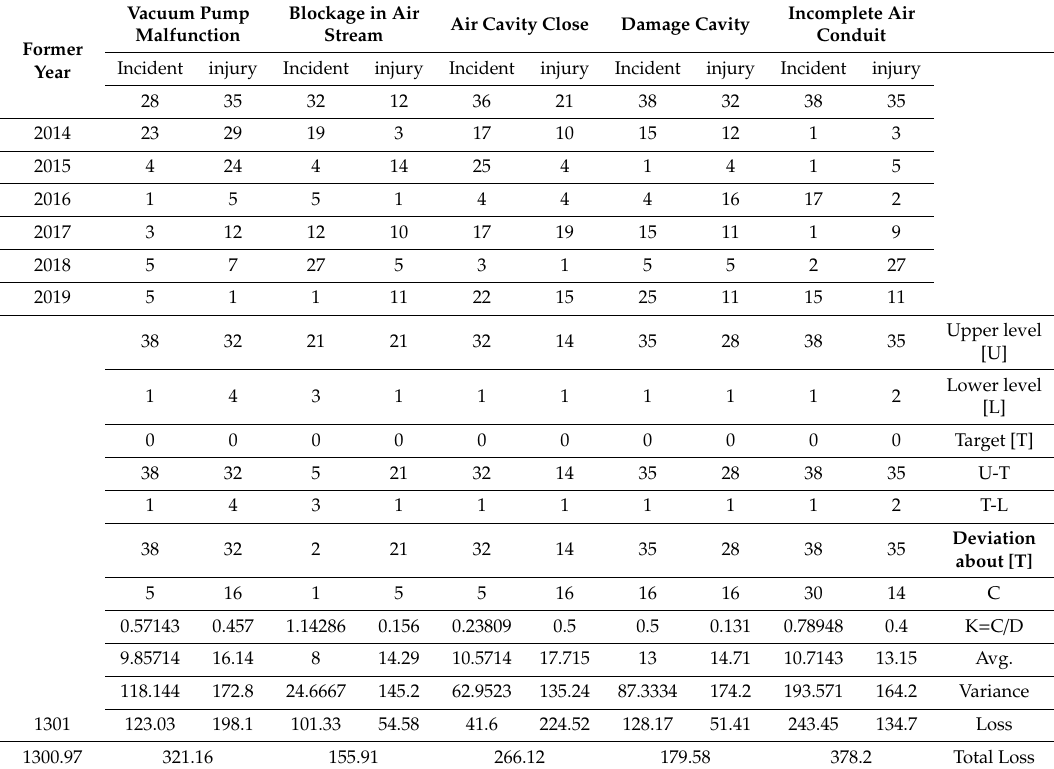
Table 15. Non-proficiency / year (faults) due to the 102,592 maintainability process for 18